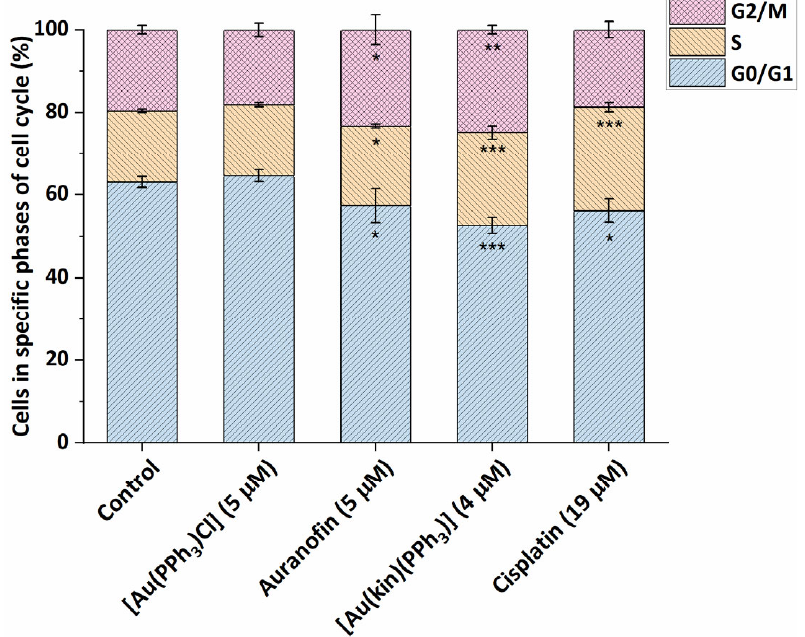
Figure 4. Modifications of the cell cycle of A2780 cells caused by the 24 h incubation of ( 1 ), starting complex [Au(PPh 3 )Cl], and reference drugs Auranofin and Cisplatin , applied at half-cytotoxic concen- tration levels. The statistical significance was considered at the following levels: * p < 0.05, ** p < 0.01, *** p < 0.001 with respect to the untreated control group.